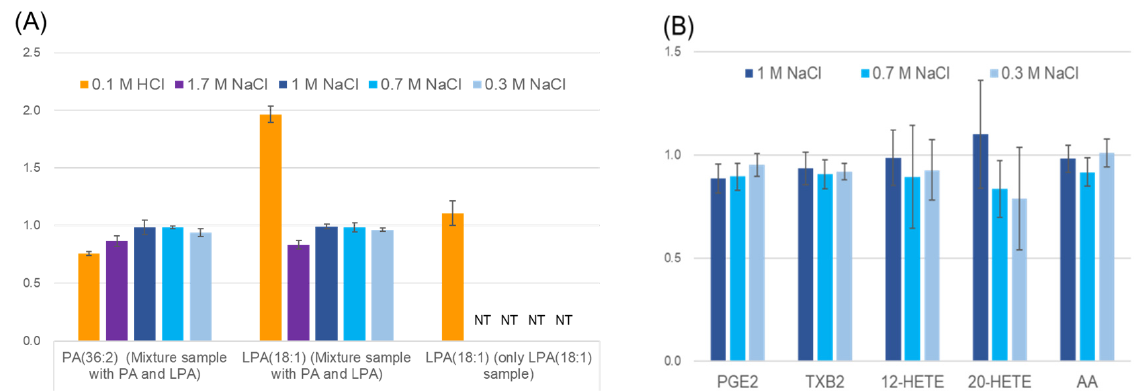
Figure 1. Examination of 1-buthanol extraction conditions. The Y -axis is the ratio of the peak area after extraction to the peak area without the extraction process. Error bars represent standard deviations. ( A ) Extraction efficiencies of phosphatidic acid (PA) and lysophosphatidic acid (LPA). The left and middle panels represent the recovery rate for 1-butanol extraction with each acidic or high salt condition. Mixture samples of 44 ng of LPA (18:1) and 50 ng of PA 18:1/18:1 (PA (36:2) in a methanol stock solution were put in test tubes. After evaporation, 330 μ L of phosphate buffered saline (PBS) was added, followed by 1-buthanol extraction with various conditions (acidic or salt). Three replicates were tested for extraction. ( B ) Extraction efficiencies of several eicosanoids. The recovery of eicosanoids and arachidonic acid (AA) by 1-butanol extraction with each salt condition is shown. A mixture of 5.1 ng of each 12-hydroxyeicosatetraenoic acid (12-HETE), 20-hydroxyeicosatetraenoic acid (20-HETE), prostaglandin E 2 (PGE 2 ), thromboxane B 2 (TXB 2 ), and AA were put in the test tube. After evaporation, 30 μ L of PBS was added followed by 1-buthanol extraction with the indicated conditions. Three replicates were tested for the extraction.